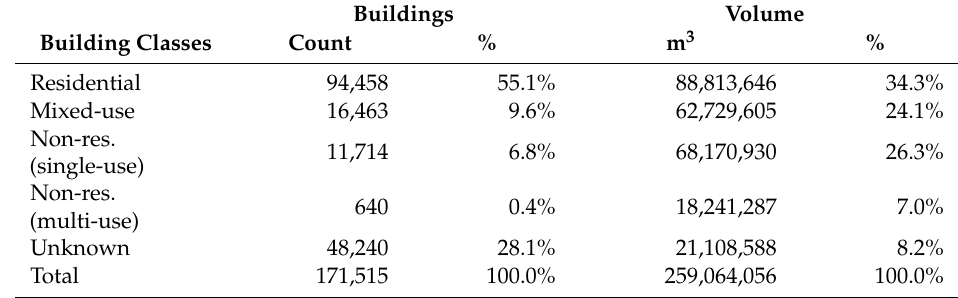
Figure 13. Example of UsageZones visualized in CesiumJS. Yellowish geometries correspond to residential UsageZones, all other colors indicate non-residential UsageZones. Table 1. Distribution of buildings and building volumes according to the five classes.